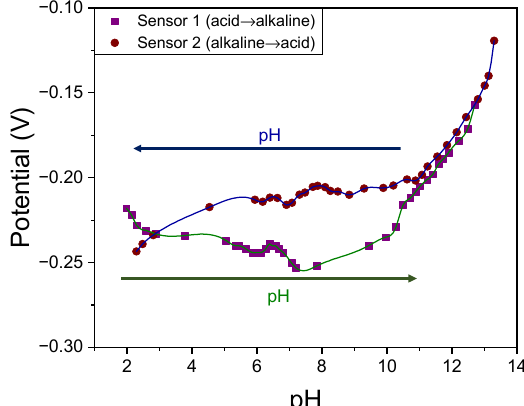
Figure 6. Study of the effect of pH on response. Chronopotentiometry measurements of NO 3 − ions at different pH. A first sensor started with low acidic pH, which steadily increased (green line), and another sensor started with alkaline pH, which decreased towards acid (blue line).